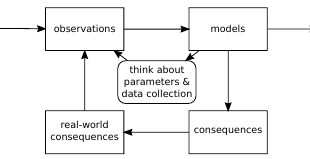
Figure 1: The Classical Modelling